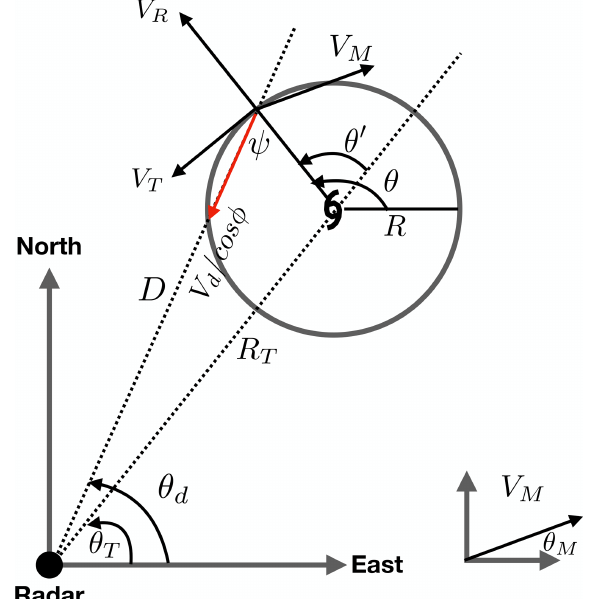
Figure 1. The geometry and symbols used in the formulation of GVTD (modified from Jou et al., 2008). The red arrow denotes the Doppler velocity. Symbols are defined in the